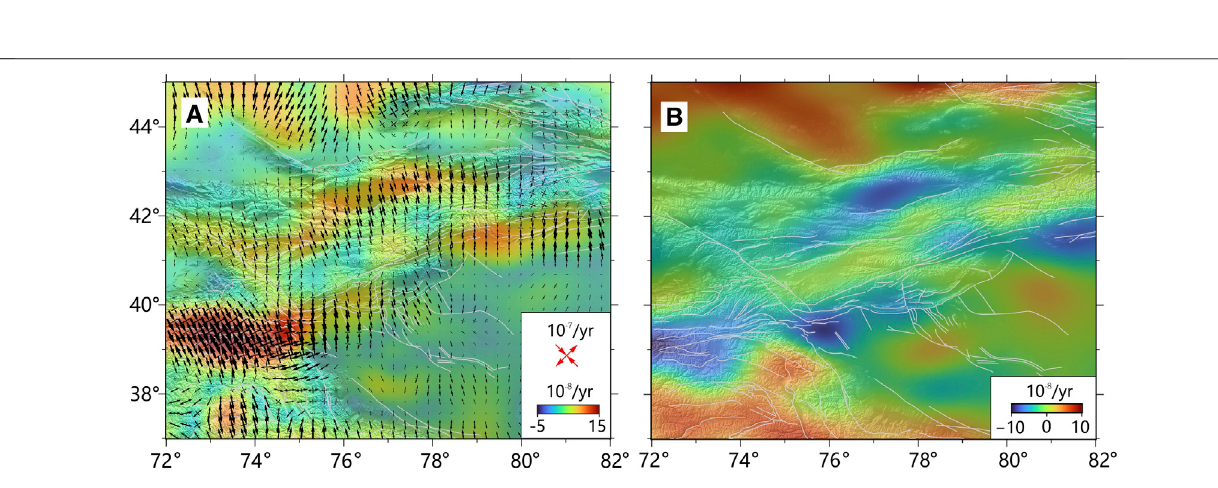
Frontiers in Earth Science |